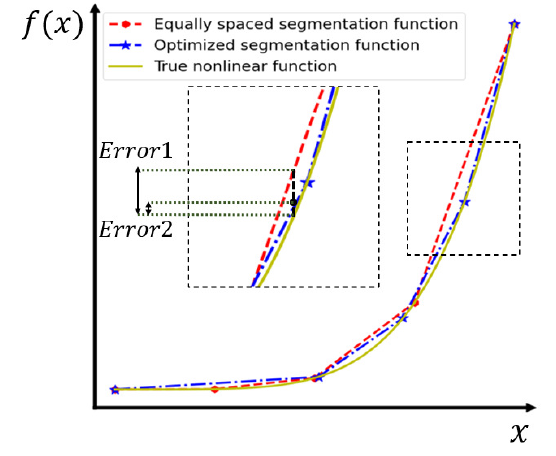
Figure 4. Piecewise linearization